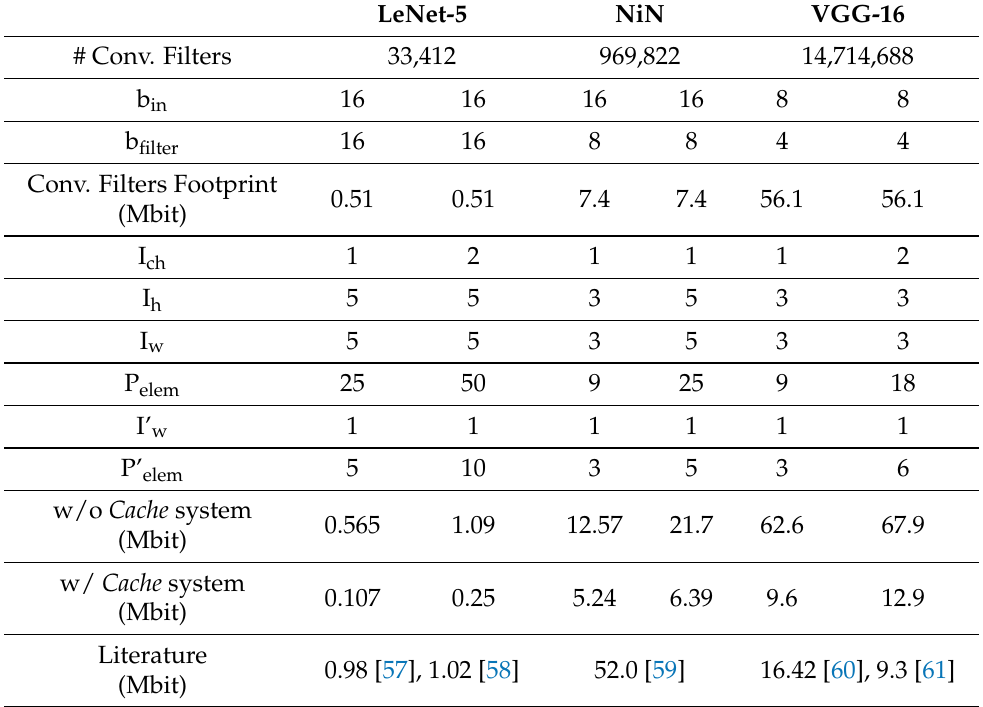
Table 6. Memory usage evaluation for different CNN